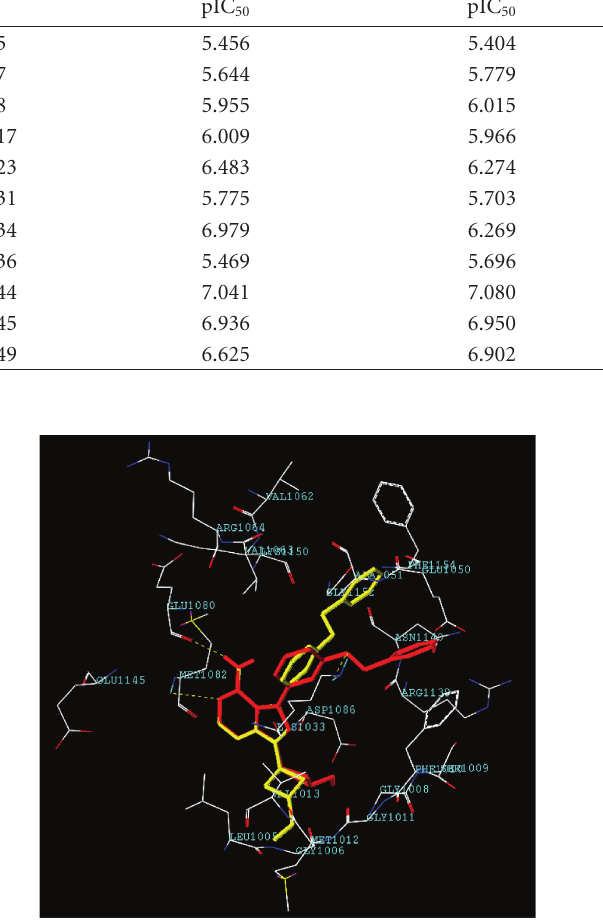
Table 5: Experimental and predicted activities with their residuals by CoMFA and CoMSIA analyses of the test set. n.